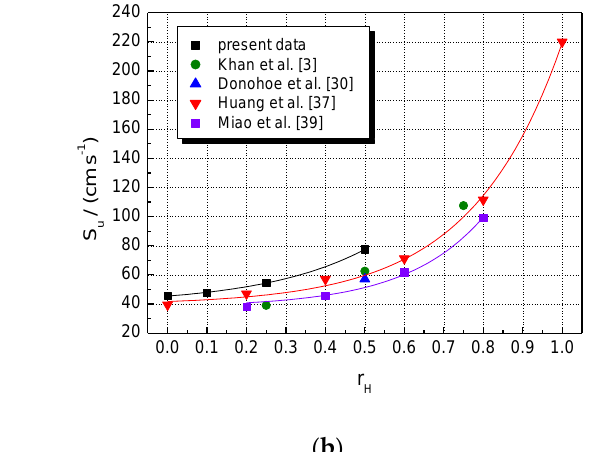
Figure 4. Computed LBV of H 2 -blended CH 4 – air and NG – air with various hydrogen contents at ambient initial conditions. For both experimental and calculated datasets, H 2 addition influences to a greater extent the LBV of CH 4 – air, as compared to NG – air. For the restricted range of hydrogen fractions 0 ≤ 𝑟 𝐻 ≤ 0.5 , the experimental relative burning velocities 𝐿𝐵𝑉 𝑟𝑒𝑙 = [𝑆 𝑢 ] 𝑓𝑢𝑒𝑙+𝐻2 [𝑆 𝑢 ] 𝑓𝑢𝑒𝑙